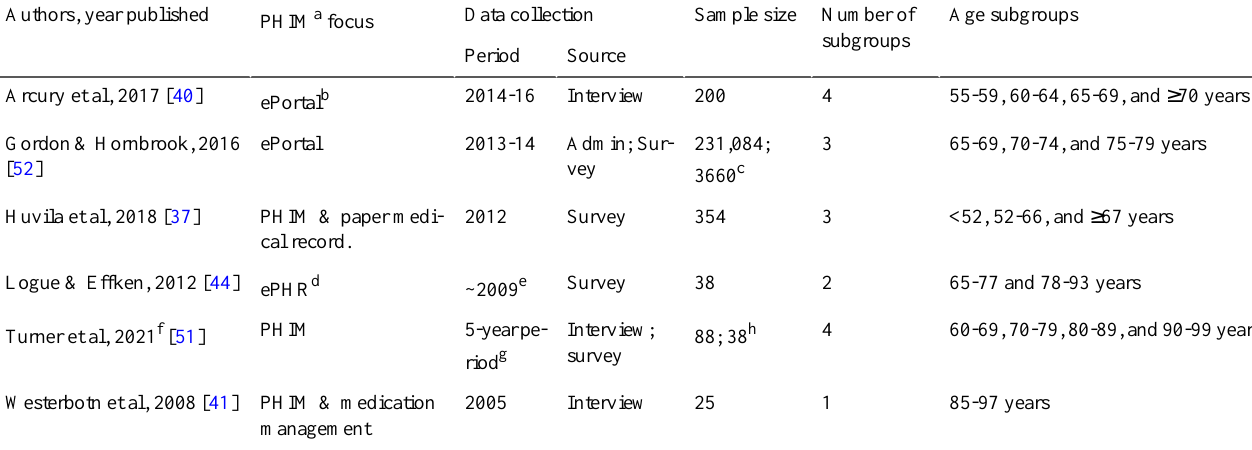
Table 1. Older adult personal health information management studies with age subgroup